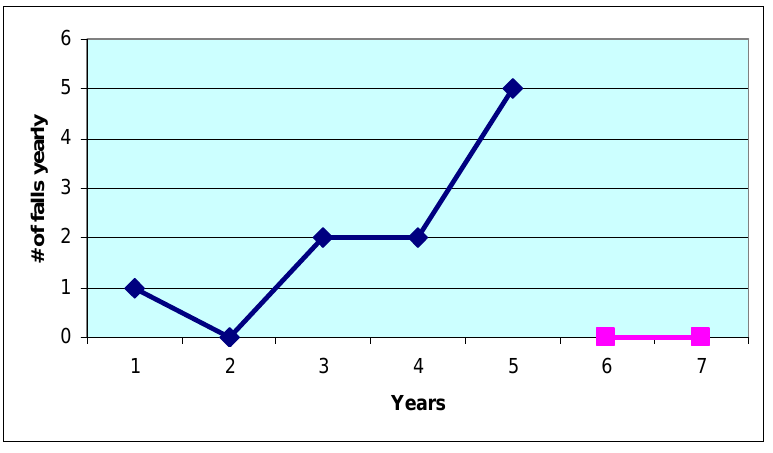
FIGURE 3. Improving balance and reducing falls through the use of the